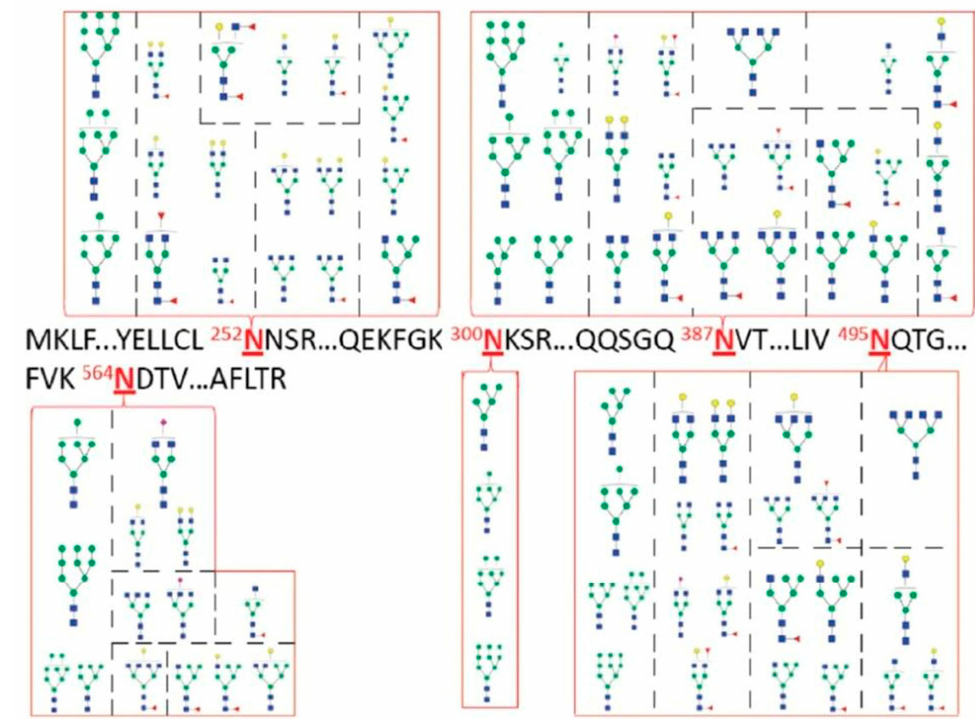
Figure 17. Glycosylation associated with each glycosite of bovine lactoferrin (b-LF). The various glycans at each site indicate glycan microheterogeneity in the occupancy of the five glycosites observed during the negative ion mode MS analysis of the b-LF glycopeptides. For each glycosite, the larger glycan structures represent corresponding glycopeptides with minimum relative intensities of 20% while the smaller glycan structures represent corresponding glycopeptides with relative intensities corresponding to less than 20%. Circles (green and yellow), squares (blue), and triangles (red) represent hexose, GlcNAc, and fucose residues, respectively. Reproduced with permission from [78]. Copyright American Chemical Society, 2010.